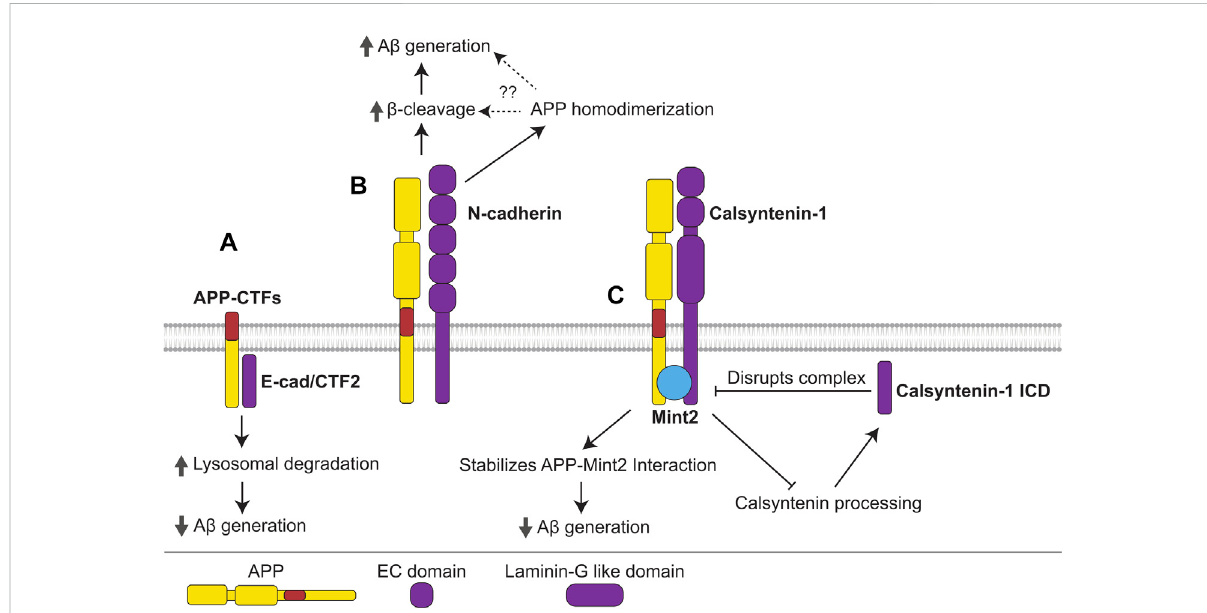
FIGURE 5 InteractionsofcadherinswithAPP. (A) The γ -cleavageproductofE-cadherin,E-cad/CTF2,interactswithAPP-CTFs,promotingtheirlysosomal degradation and precluding A β generation. (B) N-cadherin interacts with APP promoting its homodimerization, β -cleavage, and A β generation. N-cadherin-inducedAPP homodimerization maypromote β -cleavageandA β generation,however,thismechanismneedsto becon fi rmed. (C) APP formsacomplexwith thenon-classical cadherin, calsyntenin-1, and adaptor proteinMint2. TheAPP-Mint2interaction,whichmay suppress A β generation, is stabilized in the tripartite complex with calsyntenin-1, thus enabling greater suppression of A β generation. Formation of the